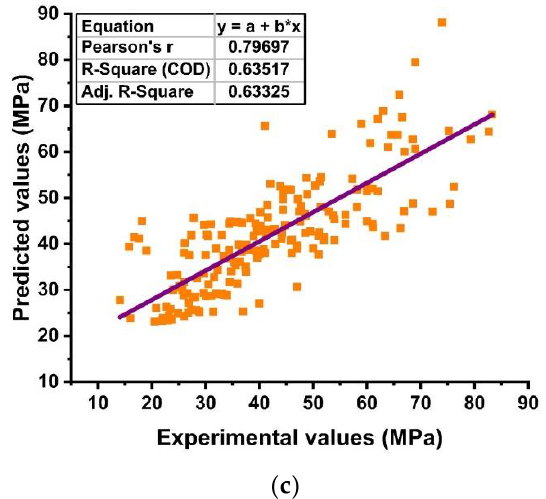
Figure 9. LR ( a ) training, ( b ) validation, ( c ) testing.